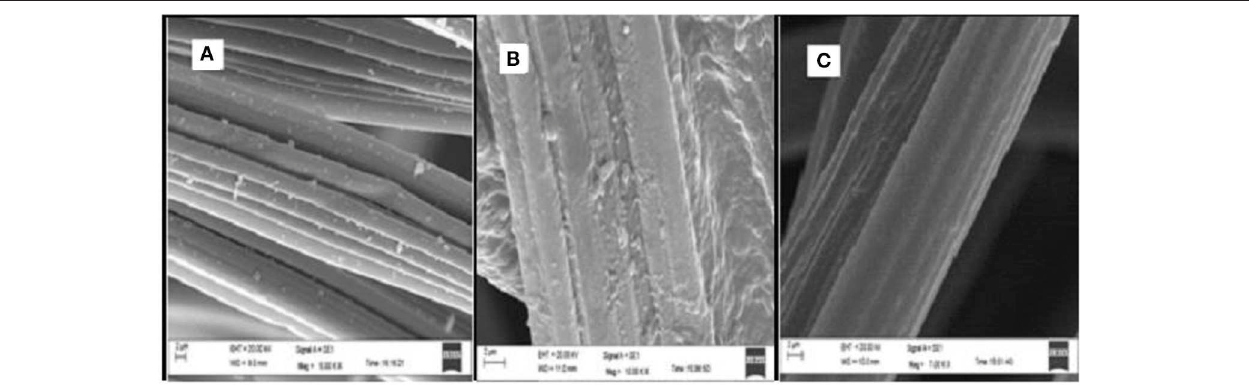
FIGURE 3 | Scanning electron microscopic images of graphite felt electrodes. (A) Plane graphite felt. (B) Graphite felt cathode post CDBT7 growth and ethanol production in the cathodic chamber. (C) Graphite felt cathode post CDBT2 growth and ethanol production in the cathodic chamber.